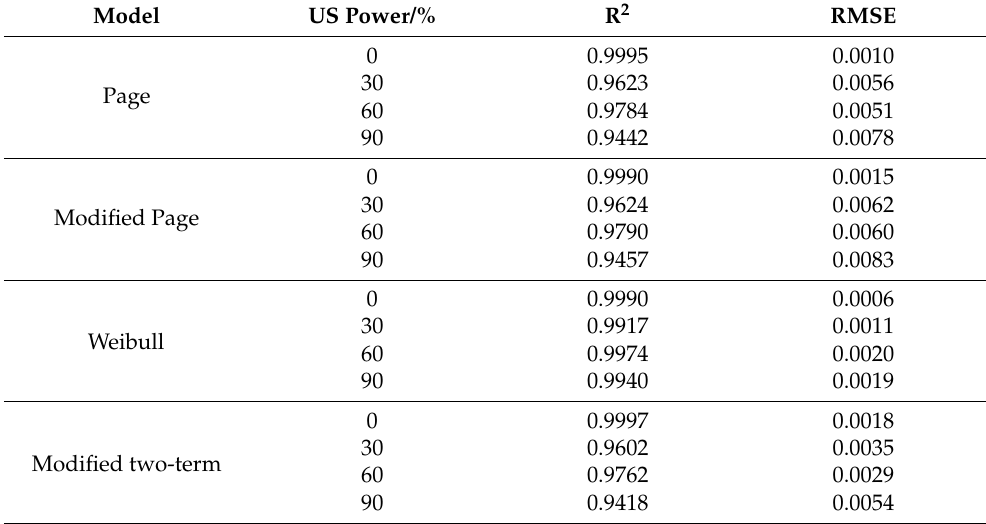
Table 2. Coefficient of determination and RMSE of selected mathematical models—30 min treatment.